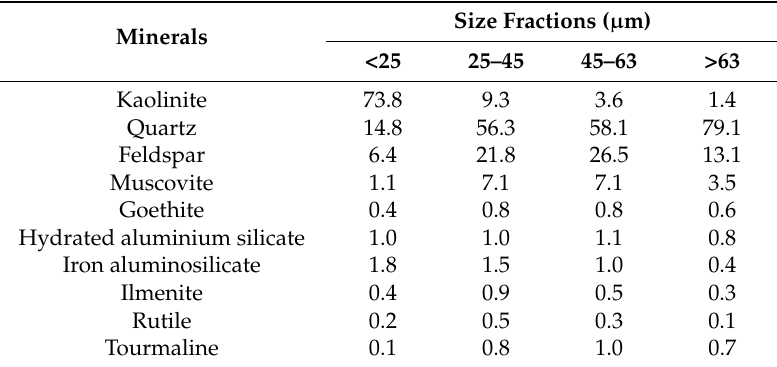
Table 1. Kaolin ore minerals, measured by electronic microprobe